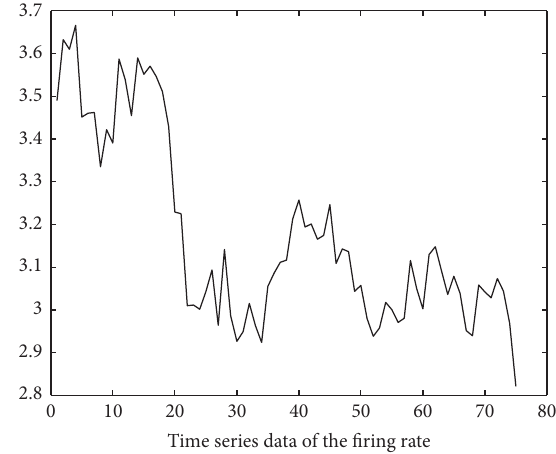
Figure 11: Firing rate series of LocateBook.